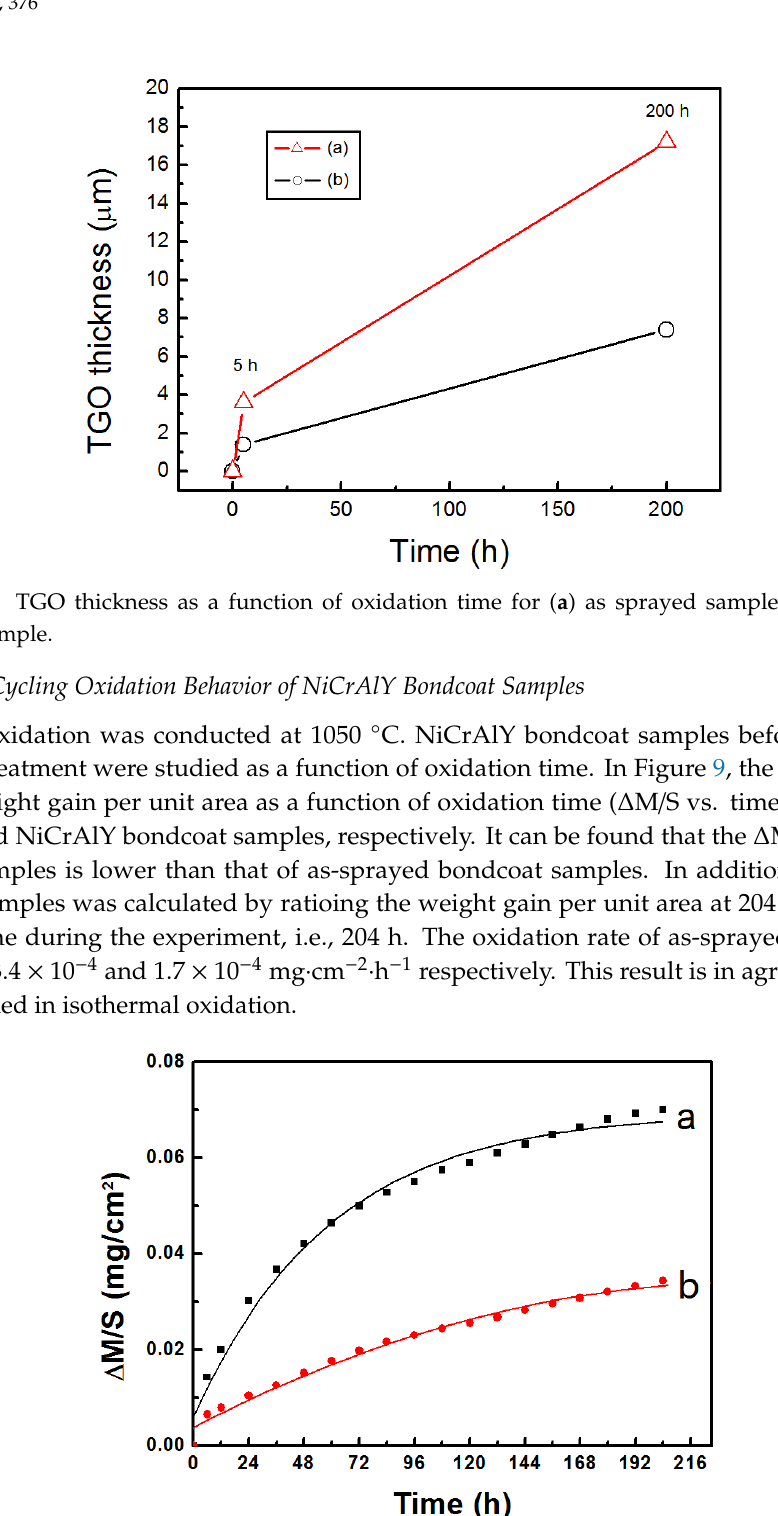
9 of 15 Figure 7. Cross-sectional morphology of bondcoat samples after oxidation for 200 h at 1200 °C ( a ) as-sprayed sample, ( b ) Al coated sample; and EDX spectrum ( c ) point A, ( d ) point B, ( e ) point C, and ( f ) point D. Table 4. Compositions data measured by EDX on the cross-section of as-sprayed and Al coated NiCrAlY samples after oxidation for 200 h at 1200 °C. Composition (wt.%)